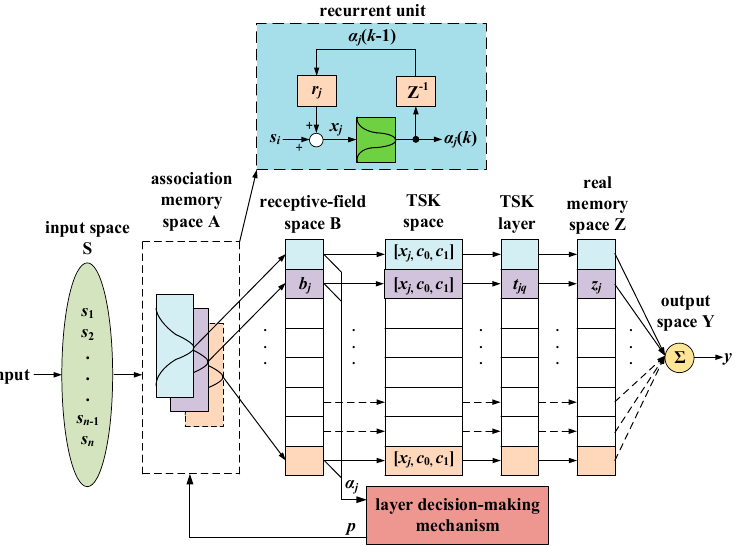
Figure 3. Takagi–Sugeno–Kang (TSK) fuzzy self-organizing cerebellar model articulation controller architecture.